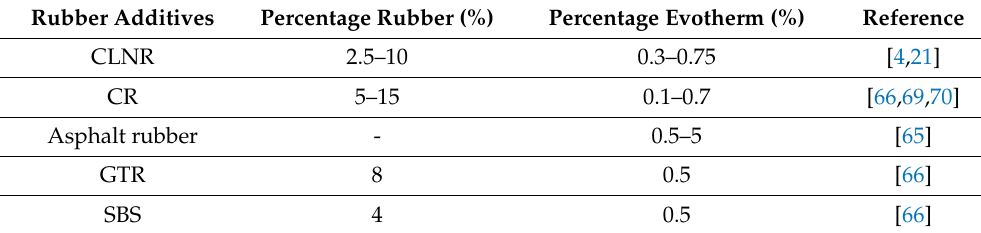
Table 8. Application of Evotherm in rubber polymers.